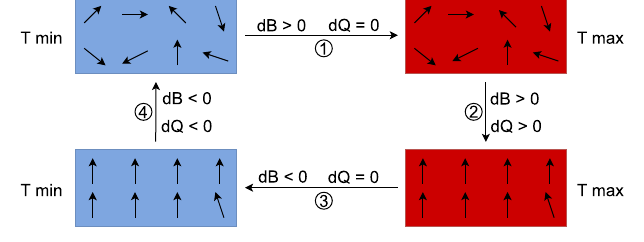
FIG. 2. Adiabatic demagnetization refrigerator